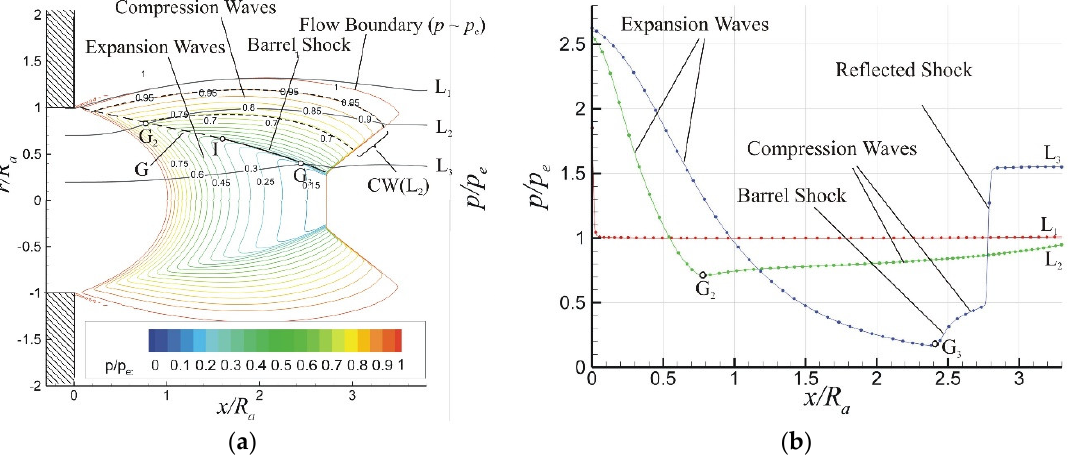
Figure 11. The passage of the streamlines through the region occupied by the compression waves: the distribution of pressure isolines in the regions of the first barrel ( a ) and the distribution of pressure along the streamlines ( b ).